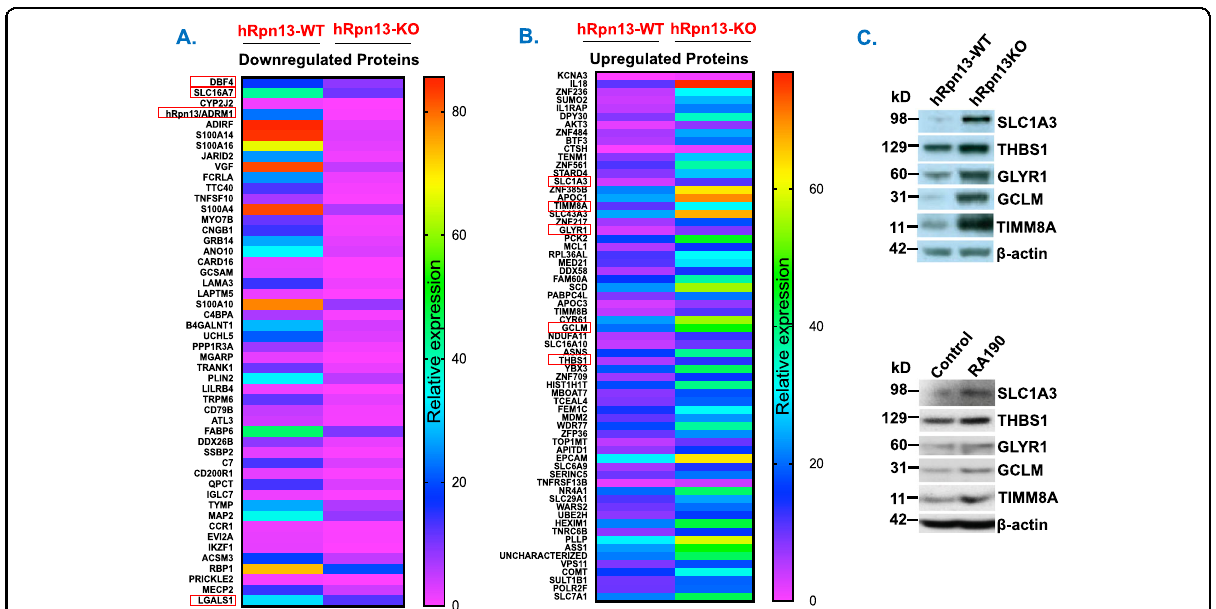
Fig. 1 Analysis of hRpn13-mediated proteomic alterations. (A , B) CRISPR-Cas9-hRpn13-KO and -WT-HCT116 cells were subjected to proteomic analysis by multiplexed proteomics with tandem mass spectrometry. Expression patterns for 50 most downregulated or upregulated proteins were compared, and heat maps were generated (>2-fold change in protein level was considered signi fi cant, CI>95%). (C) Upper panel: Total protein lysates from hRpn13-WT and -KO cells were subjected to immunoblot analysis using antibodies against SLC1A3, THBS1, GLYR1, GCLM, TIMM8A, or β -actin. Lower panel: MM.1S cells were treated with DMSO control or hRpn13 inhibitor RA190 (0.5µM) for 16h; total protein extracts were subjected to immunoblot analysis using antibodies against SLC1A3, THBS1, GLYR1, GCLM, TIMM8A, or β -actin. Blots shown are representative of three independent